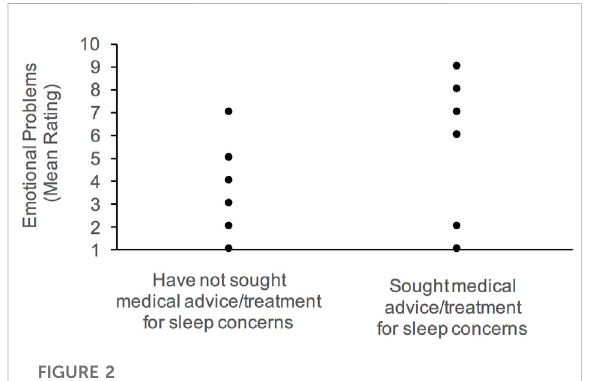
FIGURE 2 Association between emotional problems and history of medical attention for sleep